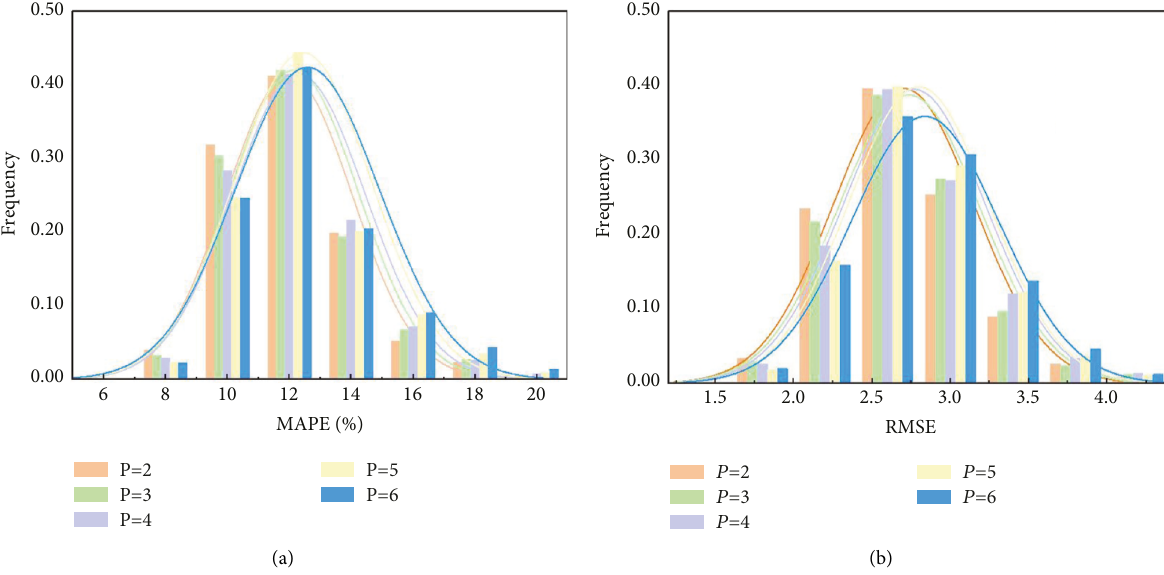
Figure 15: The error distribution of the DTBPD model with the increase of the estimation horizon. (a) MAPE; (b)